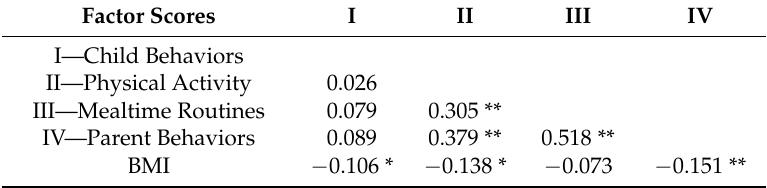
Table 4. Matrix of correlations between the scores obtained from the factor analysis and the BMI